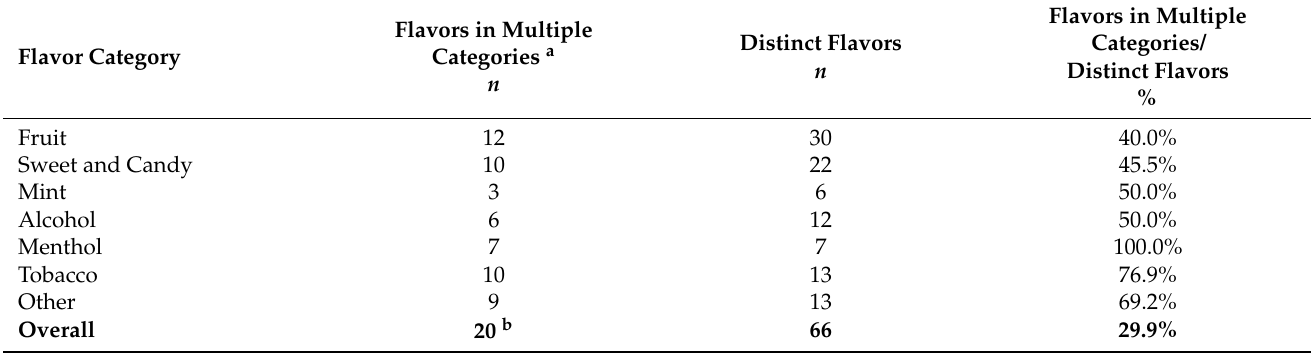
Table 4. Percentage of distinct flavors in each category that were also placed in other